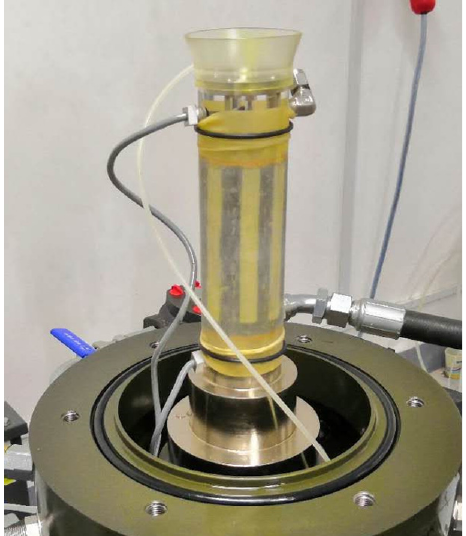
Figure 3. Installation of bender element.